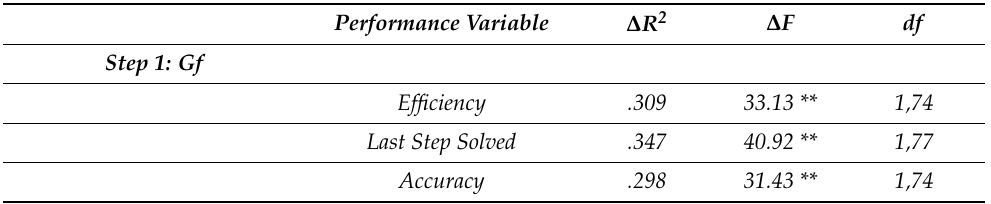
Table 4. Results of hierarchical regression